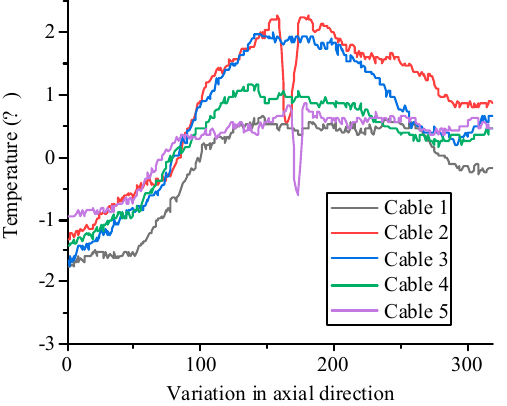
Figure 10. Temperature curve of the cable surface (the picture shows the Group #1 cables heated for 80 s).